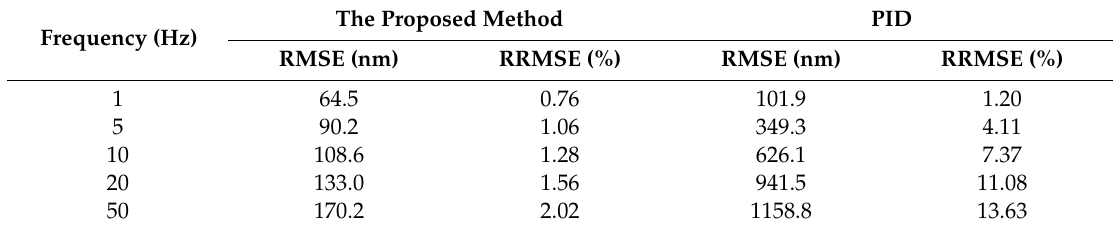
Table 1. Tracking errors of proportional-integral-derivative (PID) and the proposed approach. Frequency